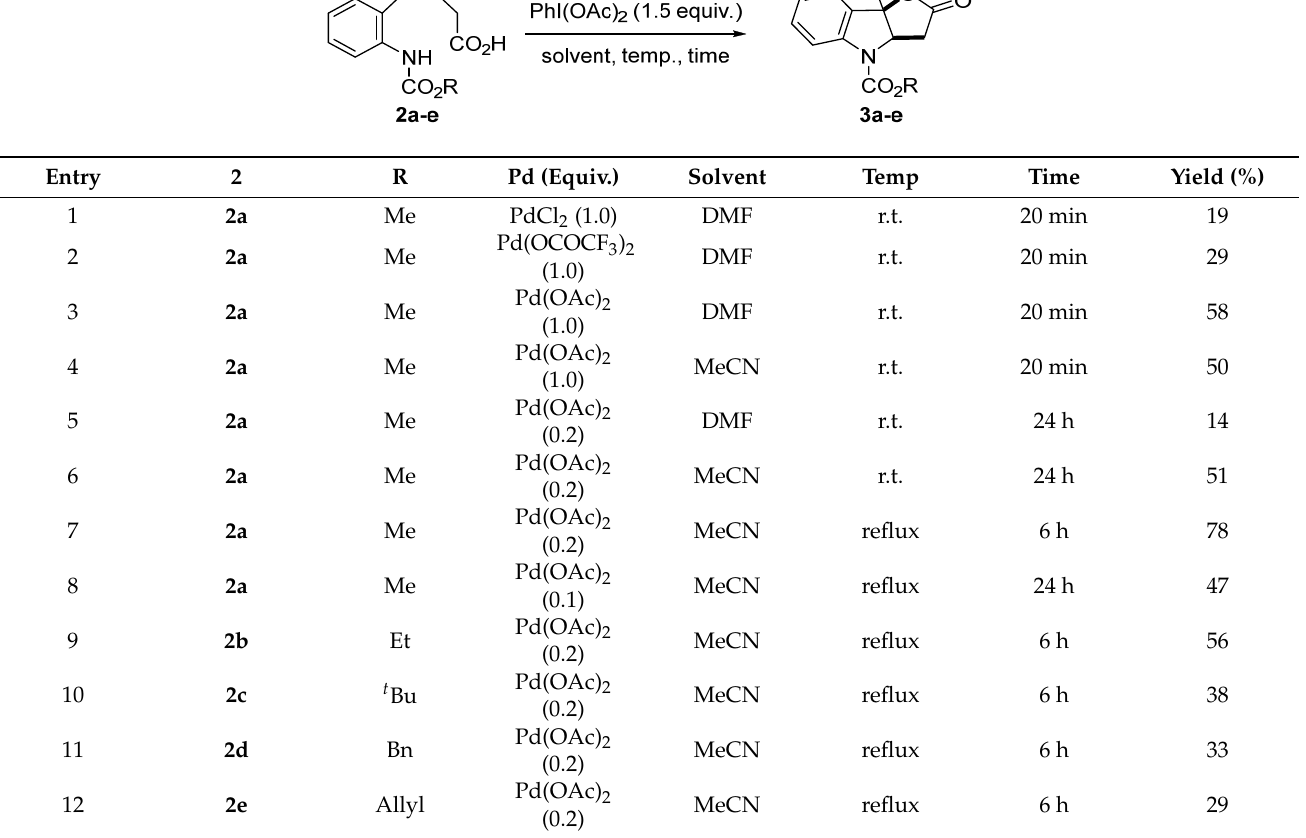
Table 2. Palladium catalyzed cyclization of alkenes 2 .